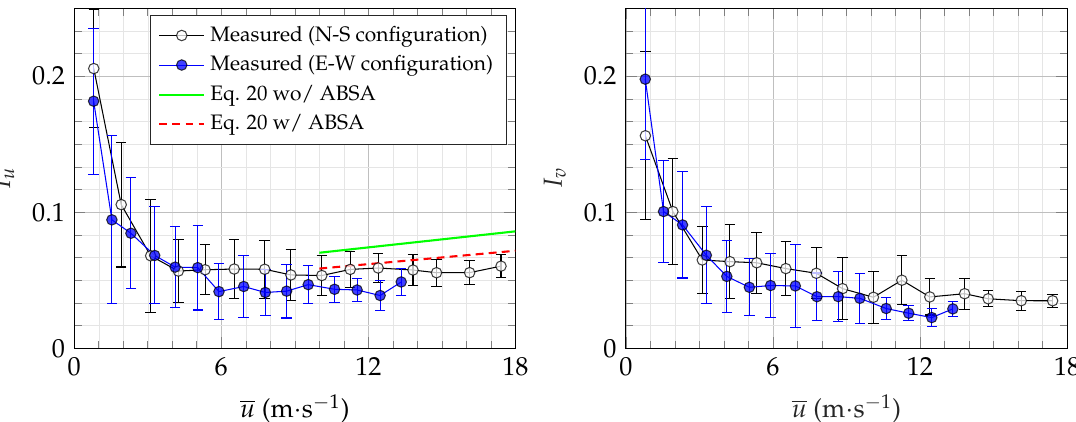
Figure 8. Along-wind and crosswind ( right ) turbulence intensity retrieved from LW2 and LE as a function of the mean wind velocity, compared to Equation (23), with and without ABSA estimated using Equations (24) and